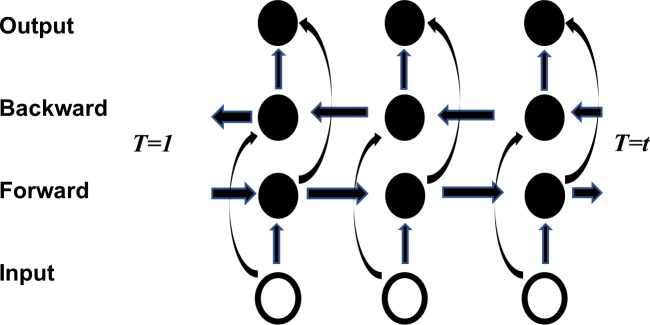
Bi-LSTM structure.